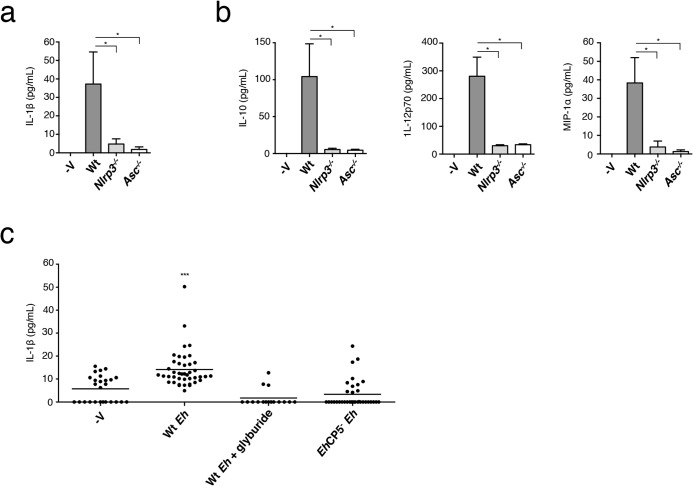
NLRP3 inflammasome is involved in E. histolytica-induced inflammatory responses of the colon.Cytokine array of IL-1β (a), IL-12p70 (b), MIP-1α (b) and IL-10 (b) of luminal secretions from colons challenged with 1 x106 Wt Eh for 3 h (n = 4 per group). *P < 0.05 (unpaired Mann-Whitney test). (c) Enzyme-linked immunosorbent assay of IL-1β secretion from normal healthy human colonic biopsies stimulated with Wt Eh with or without Glyburide (100 μM), or EhCP5-
Eh for 3 h. Each symbol represents an individual biopsy (control, n = 26; Wt Eh, n = 46; Wt Eh + Glyburide, n = 16; EhCP5- Eh, n = 36) ***P < 0.005 (unpaired student’s t-test). Data are representative of one (a, b) and three or more pooled experiments (c).